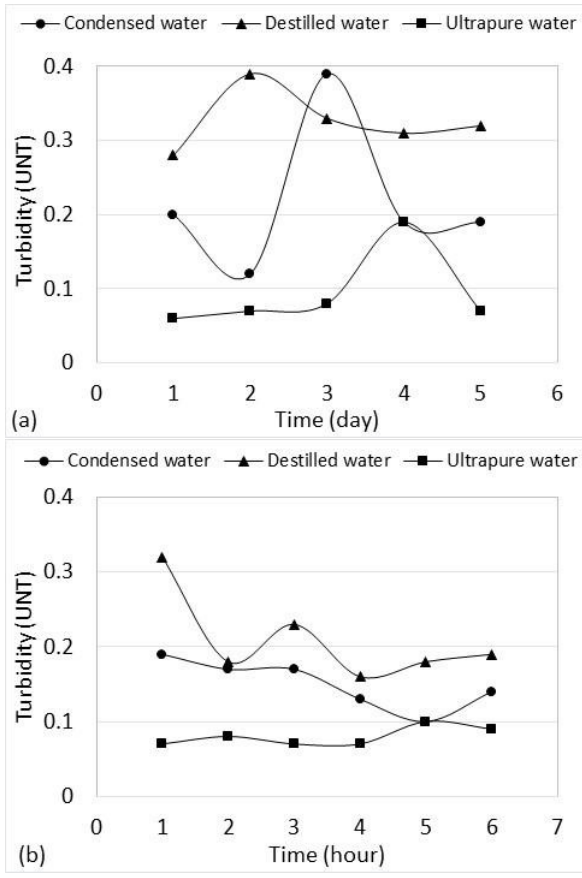
Figure 5: Turbidity values found in condensed, distilled and ultra- pure waters, with daily (a) and hourly (b) monitoring.